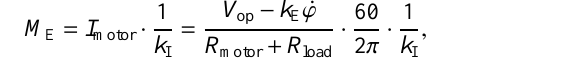
Figure 6. Transition state of the battery charging circuit.